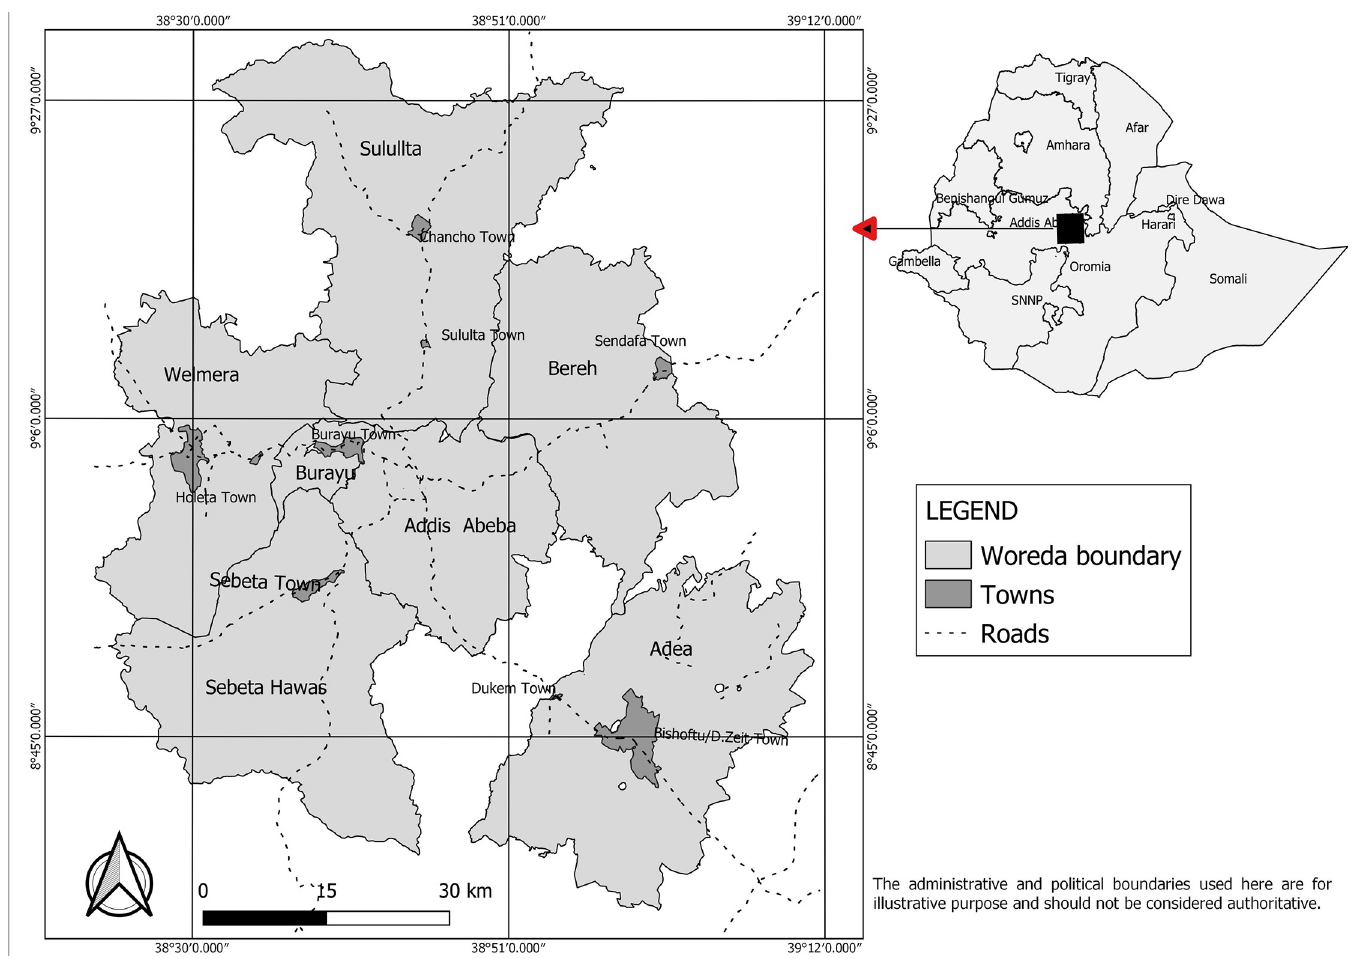
Fig 1. Map of the study areas: Addis Ababa city and Sululta, Sendafa, Holeta, Sebeta, and Bishoftu towns.